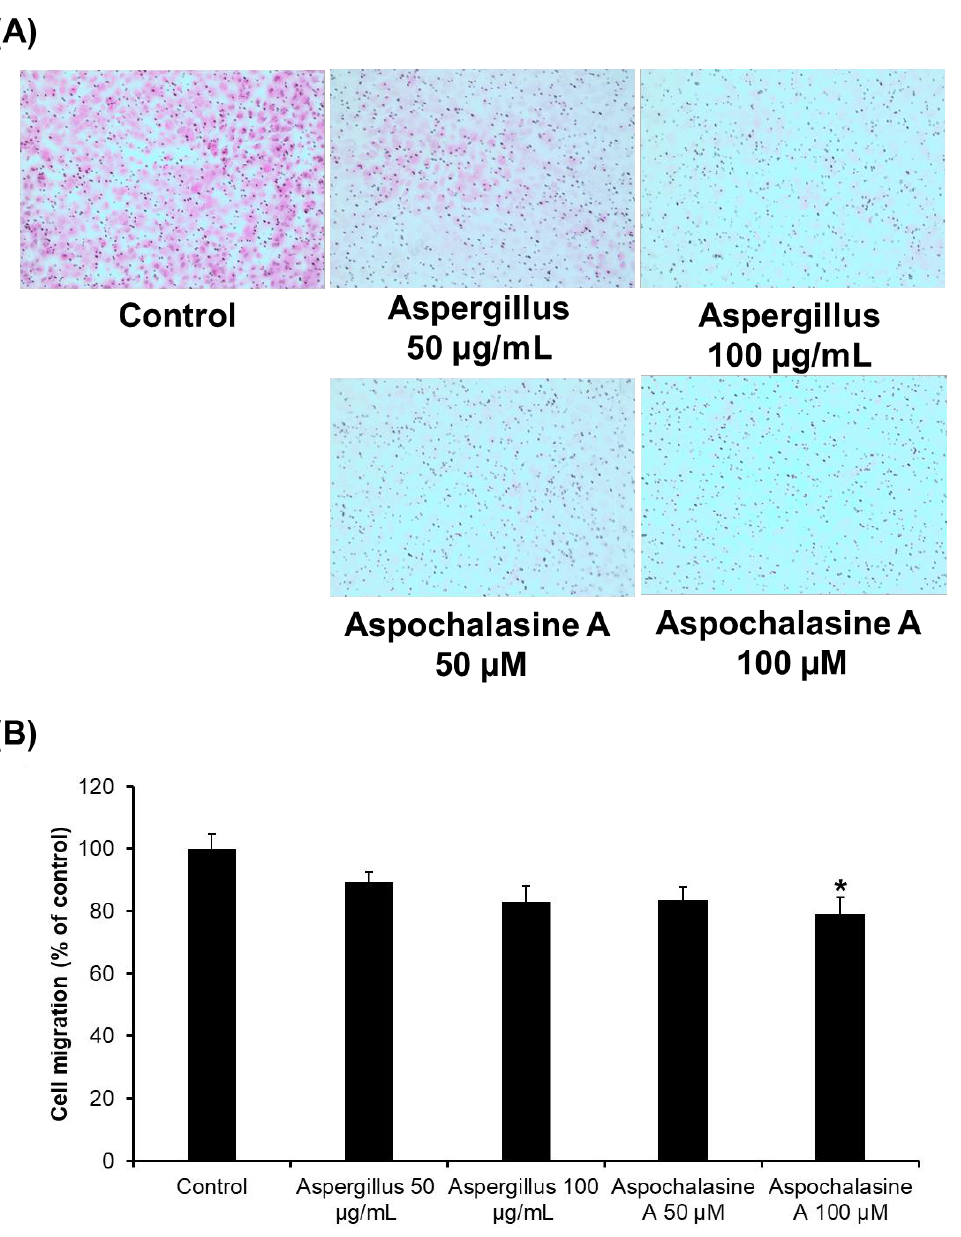
Figure 3. The effect of Aspergillus extract and aspochalasine A on HUVECs migration. ( A ) Representative images of HUVEC migration. ( B ) HUVECs were seeded into each well and treated with Aspergillus extract, aspochalasine A, or the DMSO vehicle (control) for 24 h. Cell migration was imaged and counted. Data are expressed as mean ± SEM. Similar results were obtained in three independent experiments; * p < 0.05 compared to the control value.